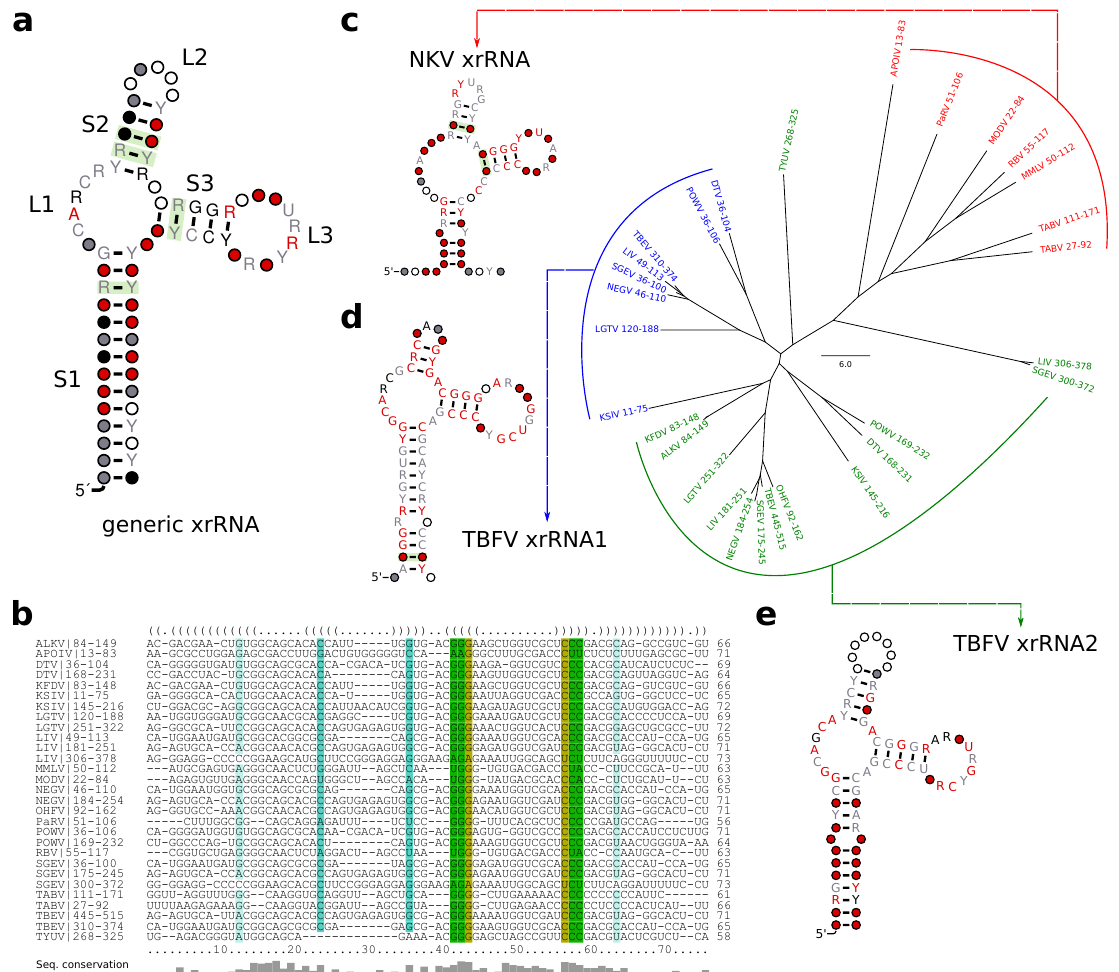
Figure 7. Generalized structure of all high confidence (cmsearch evalue < 10 − 5 ) hits of T.xrRNA1, T.xrRNA2 and N.xrRNA. ( a ) Consensus structure prediction and ( b ) structural alignment of all high confidence hits. ( c – e ) Neighbor-joining tree of all high confidence hits of N.xrRNA ( c ), T.xrRNA1 ( d ), and T.xrRNA2 ( e ). Leaves are grouped and colored by the CM used for annotation, coordinates correspond to the position in the respective 3 (cid:48) UTR. For each group a separate structural alignment was computed, the consensus structures are